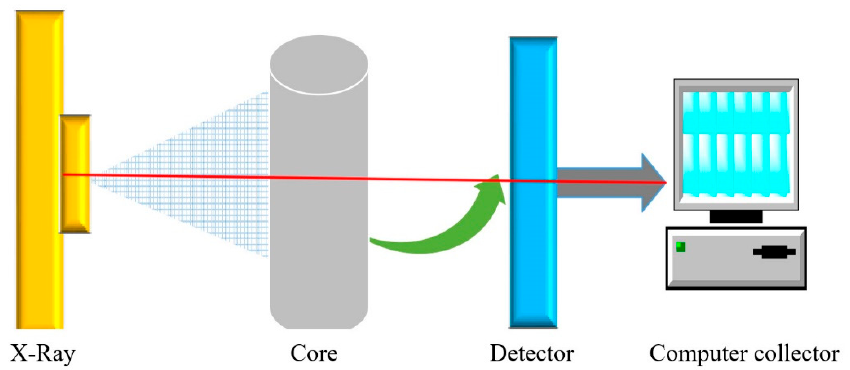
Figure 2. CT scanning device schematic.